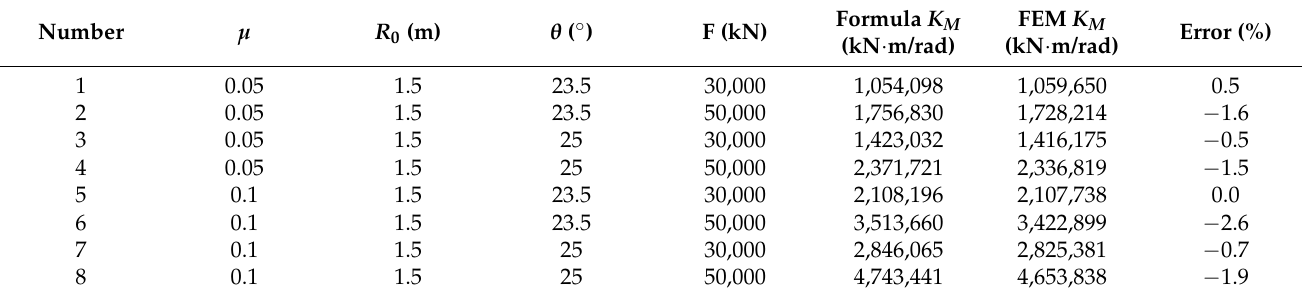
Table 1. Comparison between the proposed method and the finite element method.